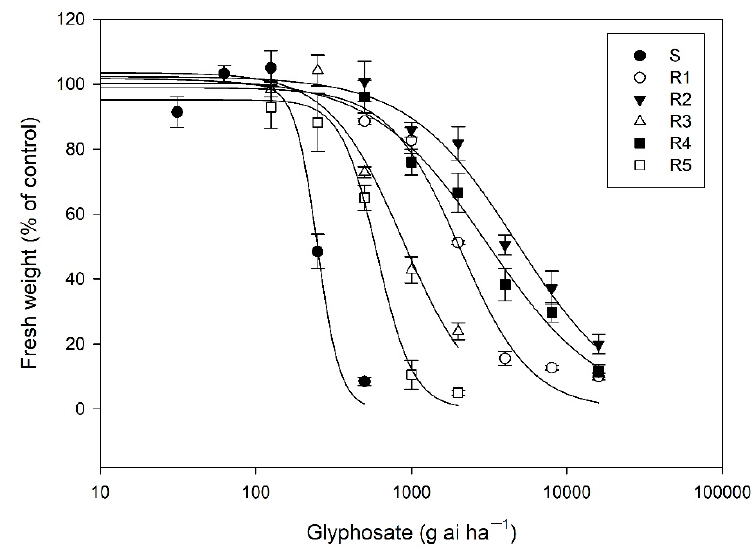
Figure 1. Dose-response curves of six E. indica biotypes to glyphosate.